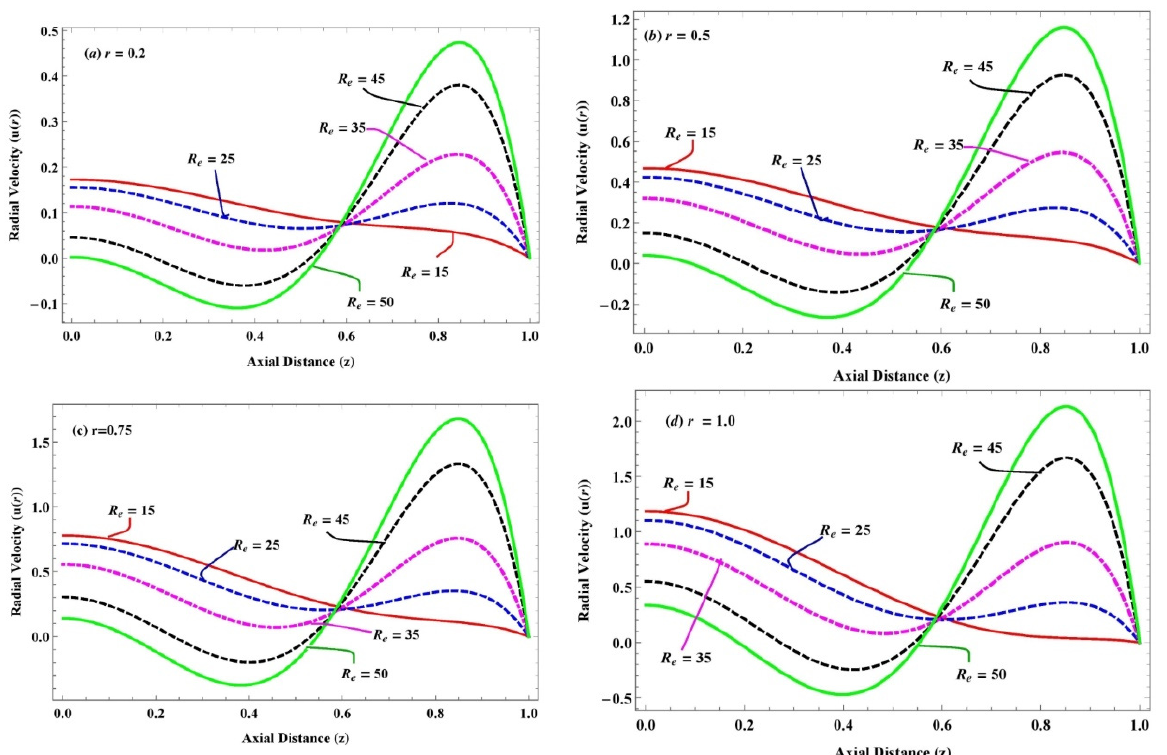
Figure 6. ( a – d ) Variation in radial velocity due to small Reynolds number ( R e ) when and β = 0.1 for ( a ) r = 0.2, ( b ) r = 0.5, ( c ) r = 0.75, ( d ) r = 1.0.